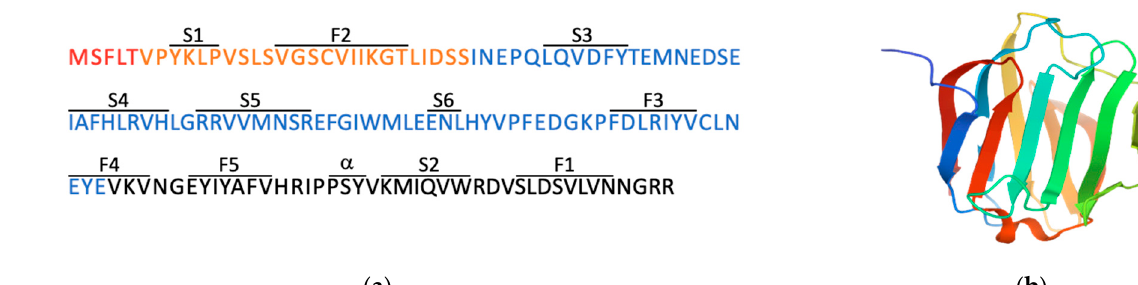
Figure 2. Protein sequence and structure of recombinant galectin-16. ( a ) The 142 amino acid sequence is 16.6 kDa for the galectin-16 protein. Each color corresponds to the exon from which the amino acids were encoded with red, orange, blue, and black representing exons 1, 2, 3, and 4, respectively. The anti-parallel β -sheets of F-face (F1–F5) and S-face (S1–S6) strands as well as a short α -helix are showed. ( b ) The crystal structure was extracted from Protein Data Bank (available online: rcsb.org, accessed on 6 September, 2021), PDB ID: 6LJP.